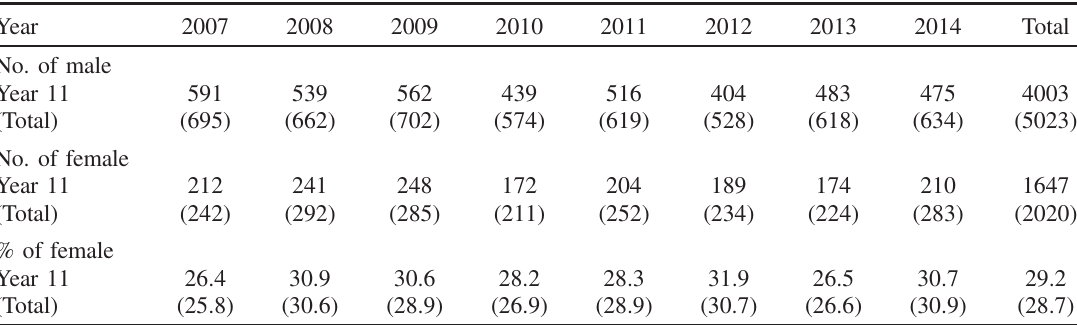
TABLE I. The numbers of (self-identified) male and female students in each cohort. The total is slightly less than the number of students who took the exam, as not all students identified their gender. Figures in parentheses include students in years other than year